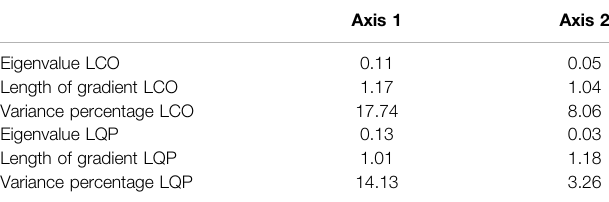
TABLE 2 | DCA results of the abundance of fossil pollen from Laguna Corralito (LCO) and Laguna Quebrada Parada